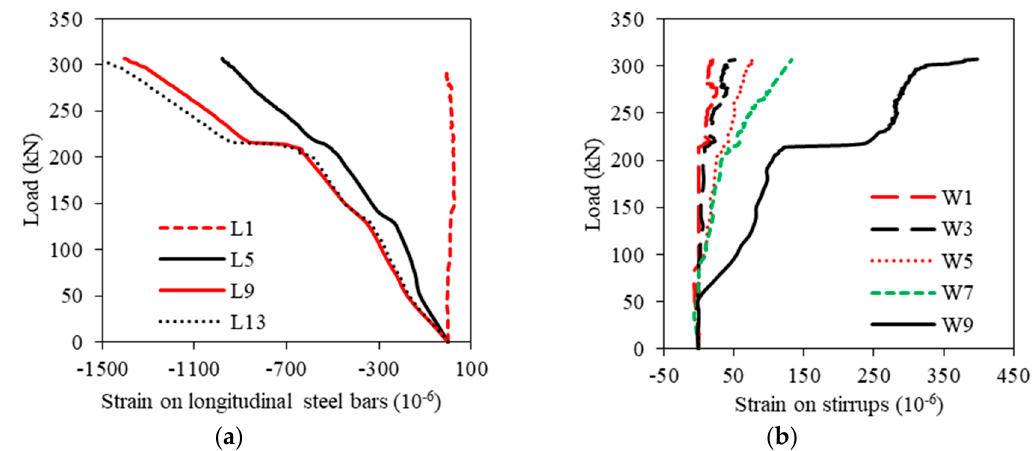
Figure 10. Load versus the strain of ( a ) the longitudinal bars, and ( b ) the stirrups.